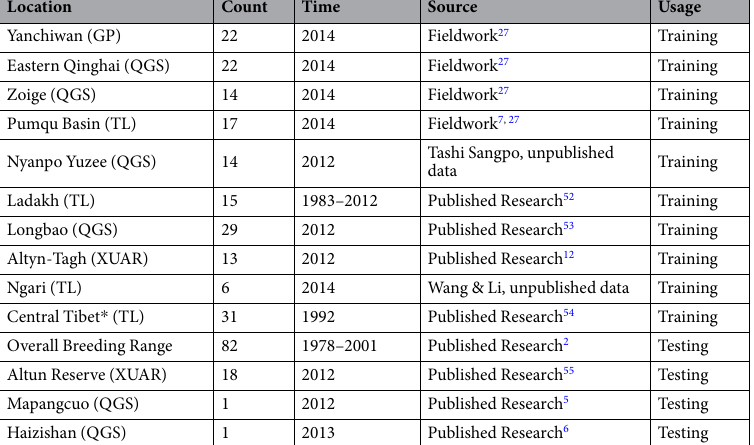
Table 1. Detailed Distribution Data and Sources. Nests shown in maps were referenced in ArcGIS 10.1 (ERSI co., USA) to obtain a decimal longitude and latitude with five decimals (using the Georeferencing tool in ArcGIS). In the first column, “TL” represents central and southwestern Tibet and Ladakh; “QGS” represents part of Qinghai, Gansu and Sichuan Provinces; “GP” represents northwestern Gansu Province; and “XUAR” represents the southeast corner of Xinjiang Uygur Autonomous Region. * Nest locations presented were only accurate to the geographic minute in the literature (two sites thus